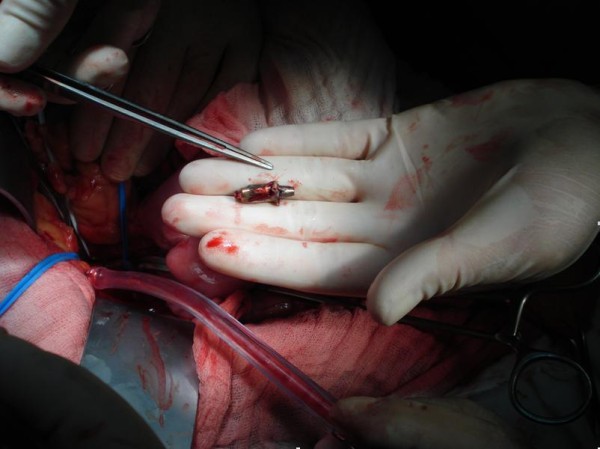
Extracted bullet.